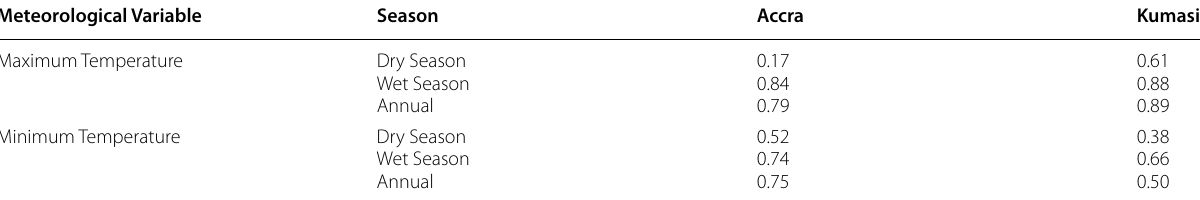
Table 3 Lag 1 serial correlation coefficient